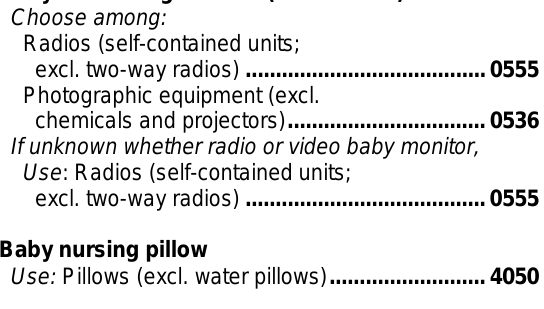
Baby oil Code only for poisonings or chemical burns to children under 5 years of age Baby pillow wedges/sleep positioners Use: Baby mattresses or pads (excl. Baby powder Code only for poisonings or chemical burns to children under 5 years of age